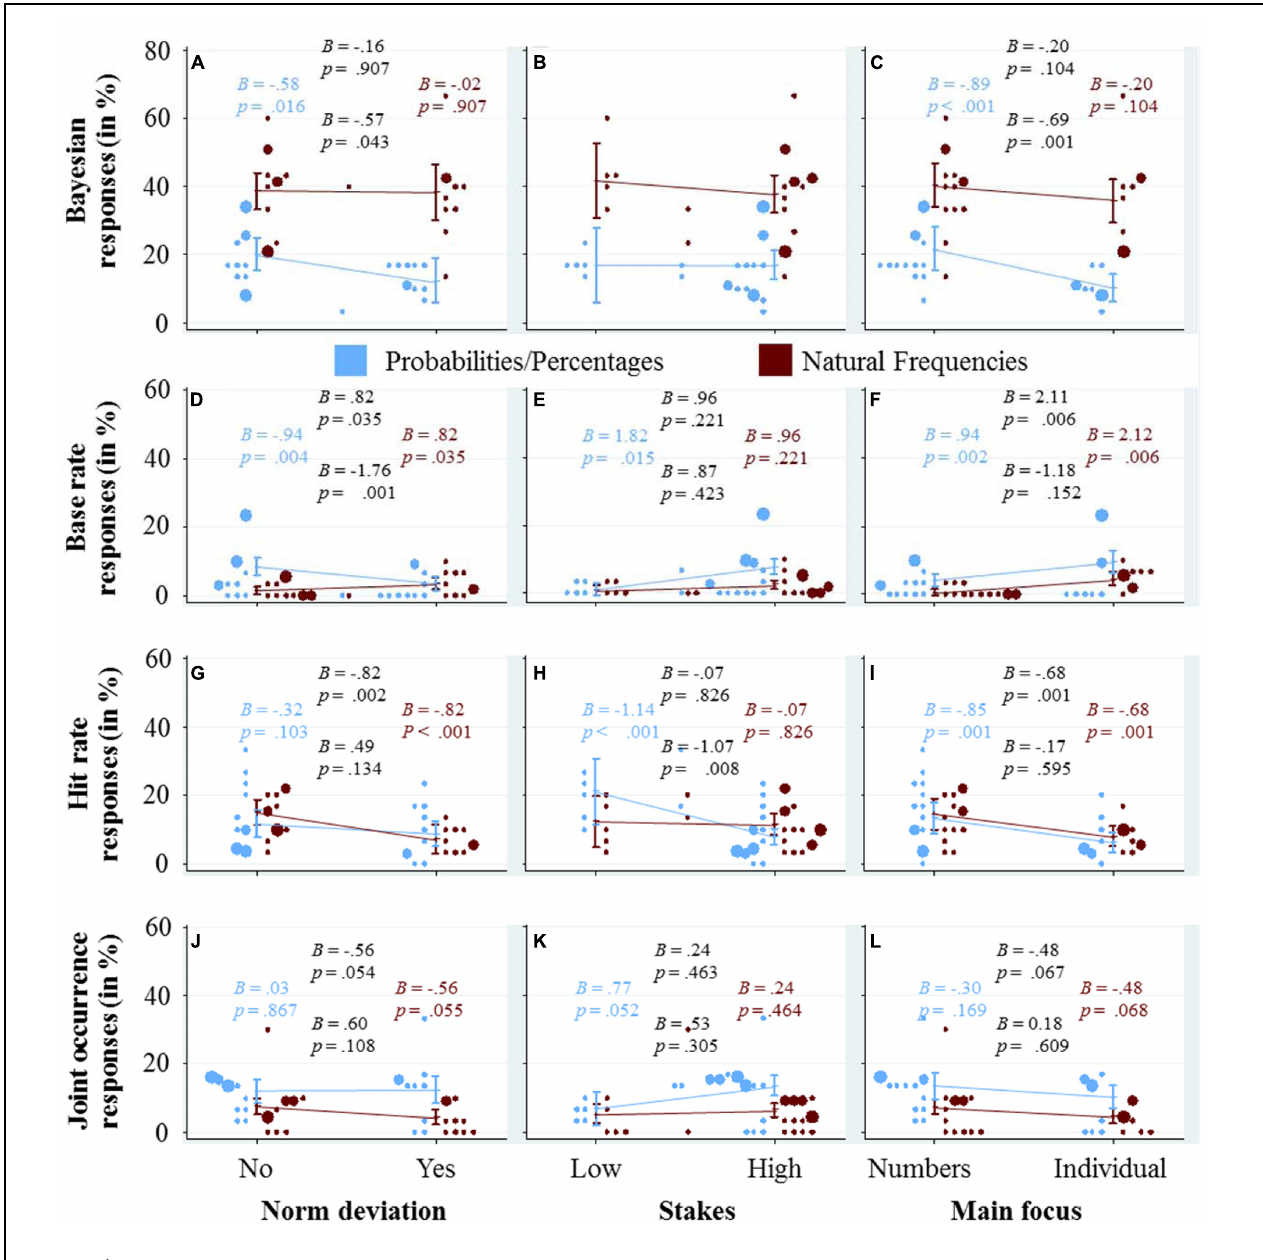
confidence intervals are based on logistic regression analysis with strategy use as the dependent variable, following the same specifications as the regression analyses used for Figure 3 (see the caption of this figure for details). We included four coefficients and corresponding p -values in each panel (see also the caption of Figure 2 for